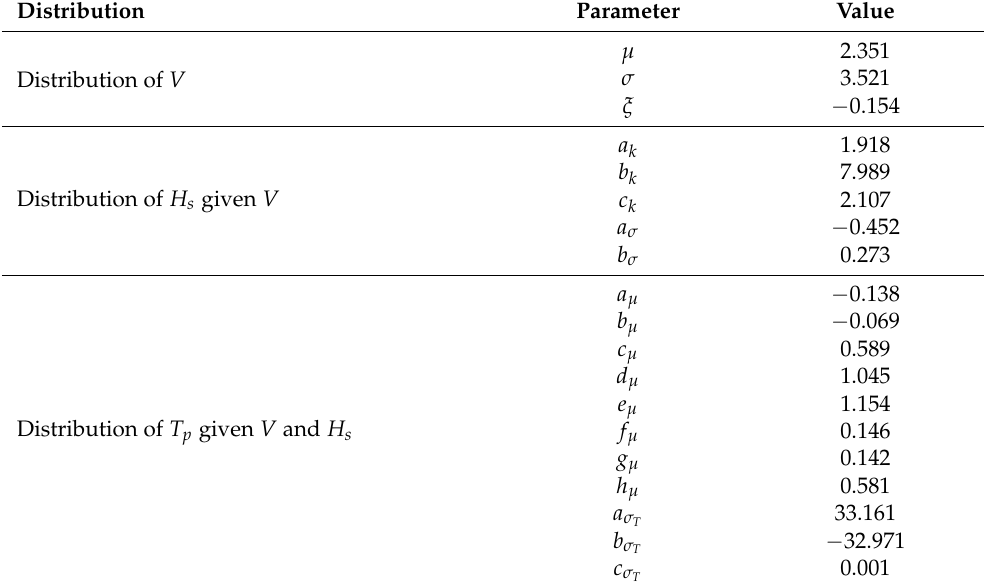
Table 1. Probabilistic model